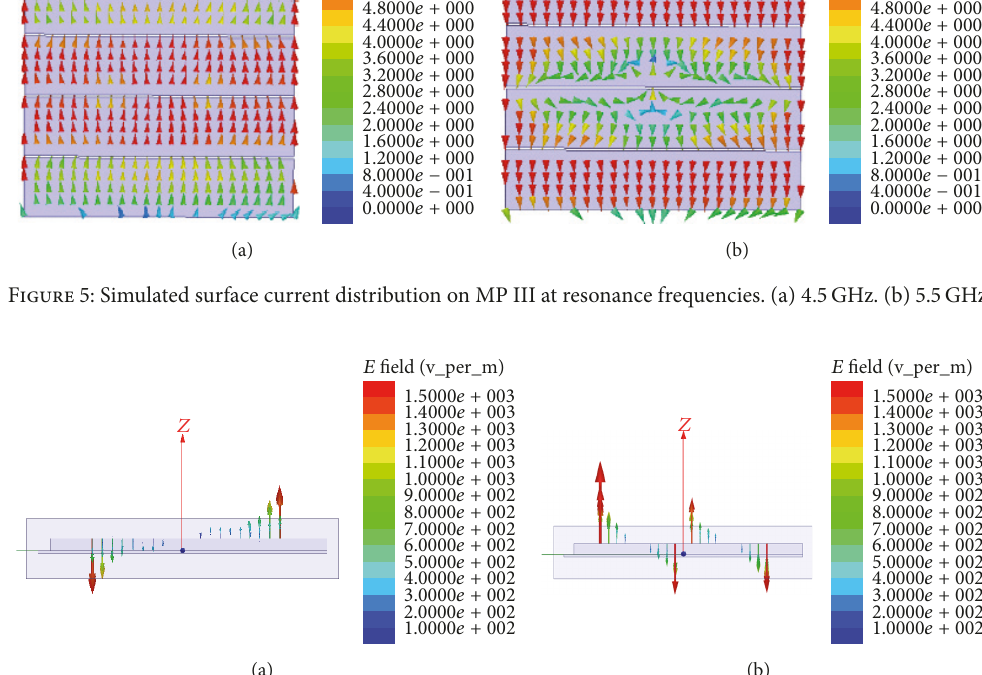
Figure 6: Simulated 𝐸 -filed distribution on 𝑦 = 0 mm planes of MP II at resonance frequencies. (a) 4.5 GHz. (b) 5.5 GHz.